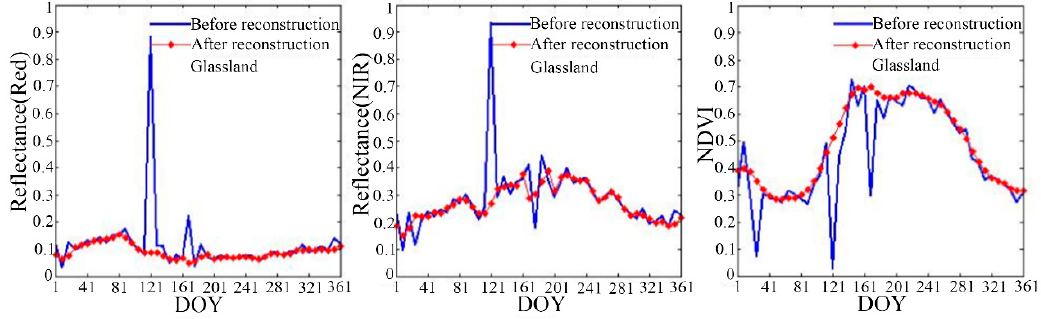
Figure 5. The VIIRS surface reflectance of the red and NIR bands as well as NDVI before and after reconstructions at ARM/CART Shilder site (Lat: 36.93°, Lon: − 96.86°) in 2013.